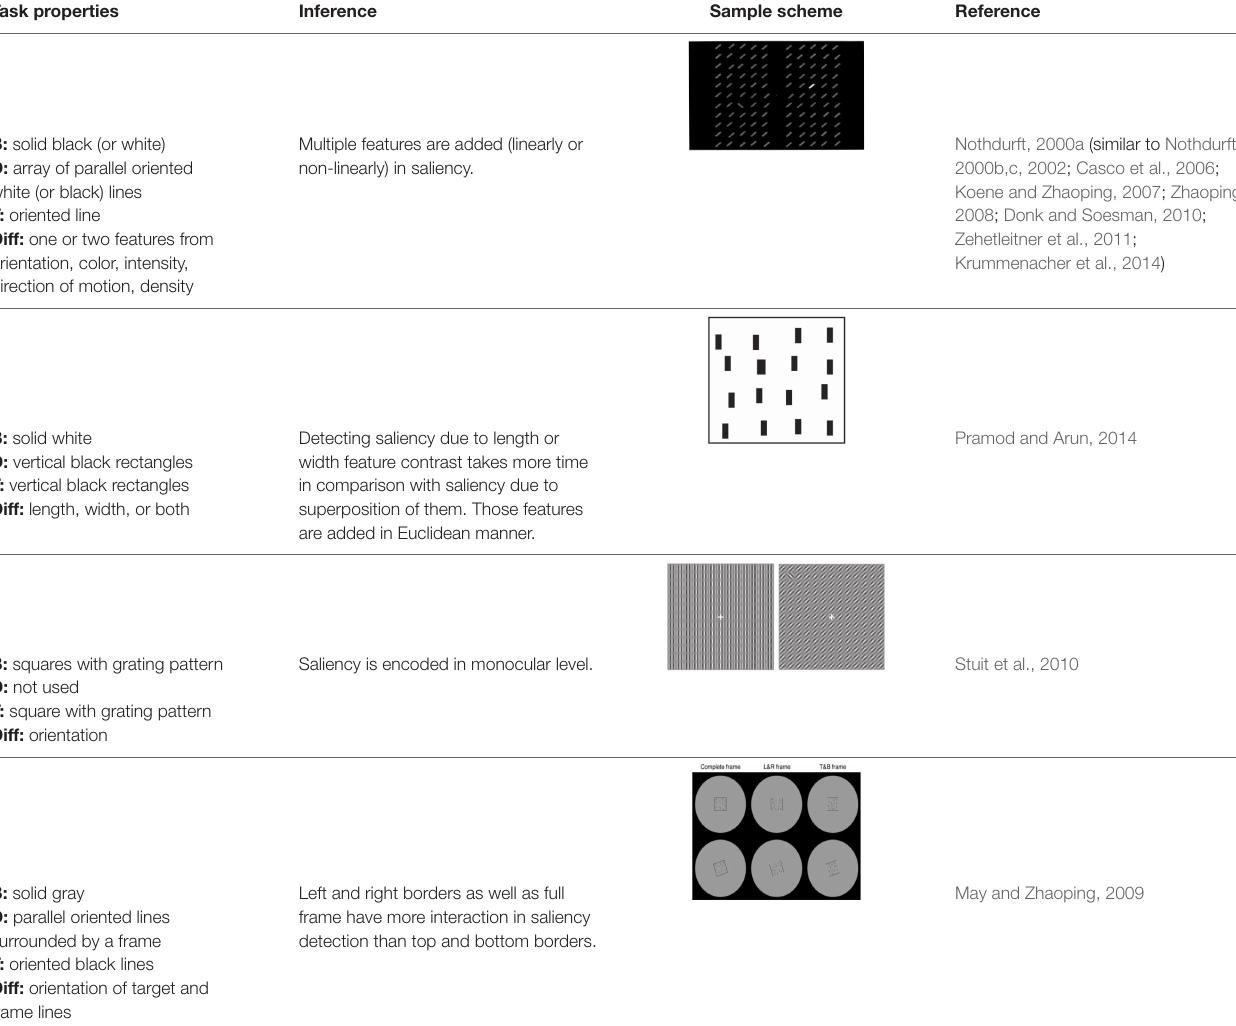
TABLE 1 | An overview of common visual pop-out experiments. Task properties Inference Sample scheme